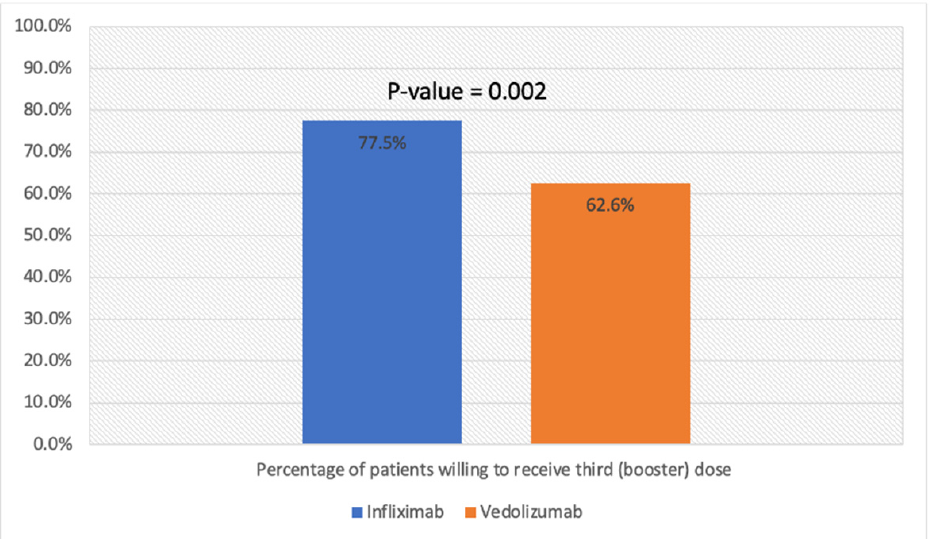
Figure 2. Percentage of patients willing to receive third (booster) dose stratified by biologic therapy.